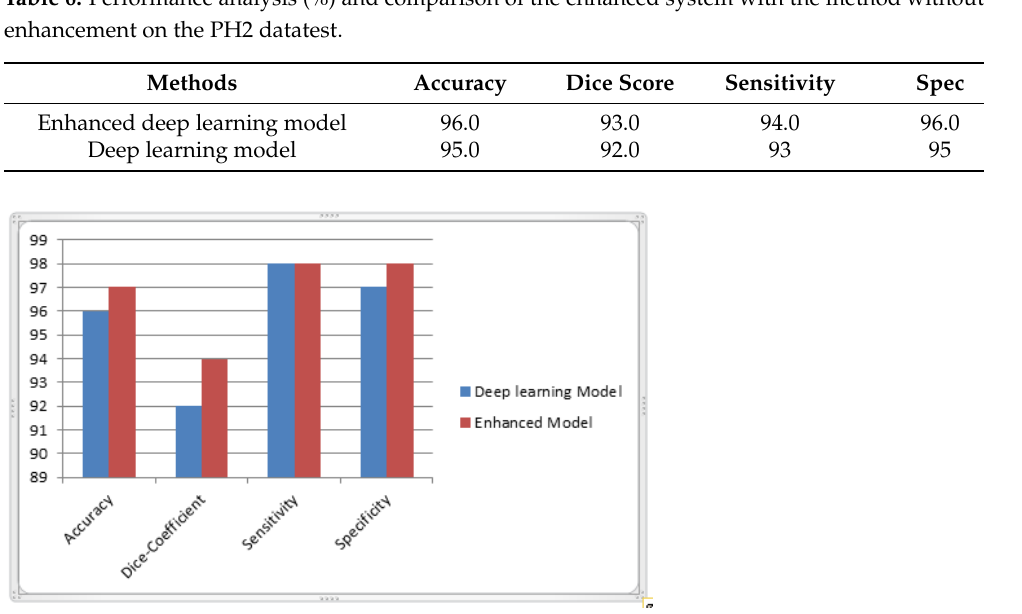
Figure 4. The figure shows the performance of the deep learning model against the enhanced method on ISBI 2017 skin lesion images .